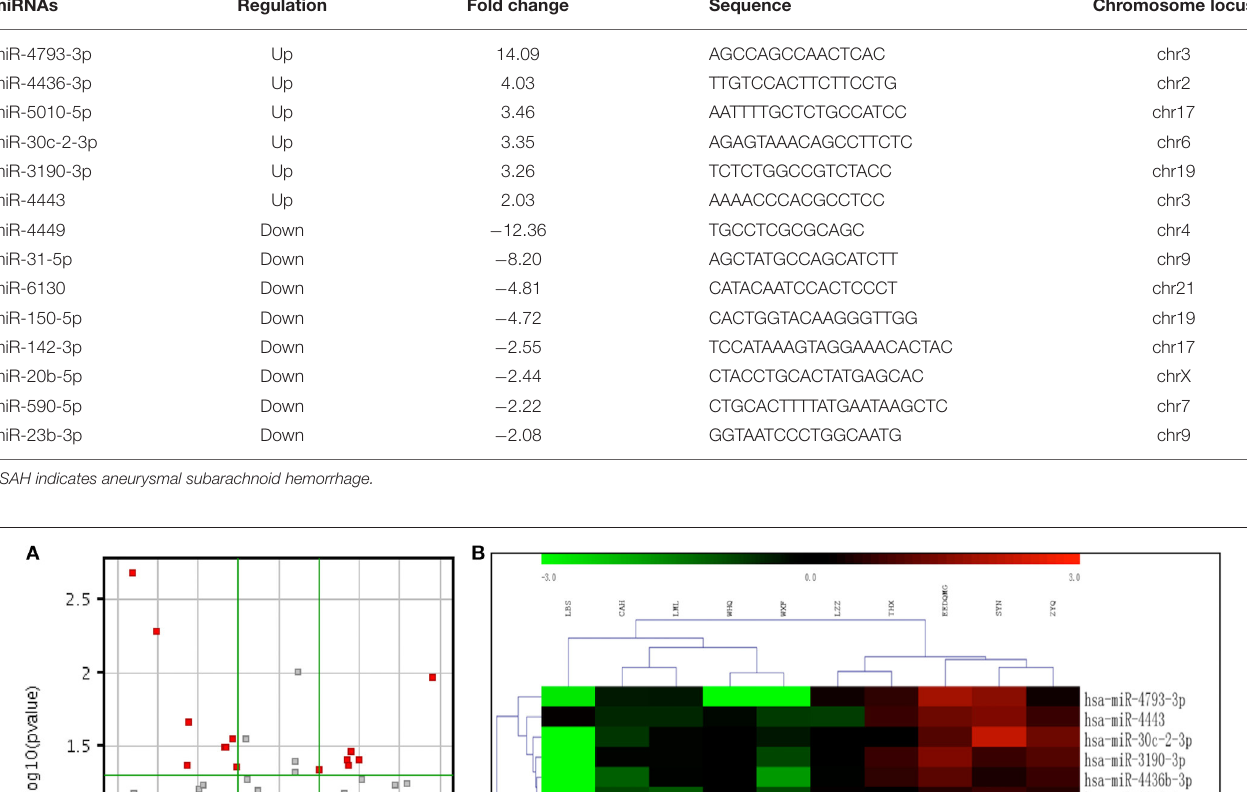
TABLE 3 | Plasma miRNAs with significant differences between aSAH patients and controls, as determined by microarray. miRNAs Regulation Fold change Sequence Chromosome locus